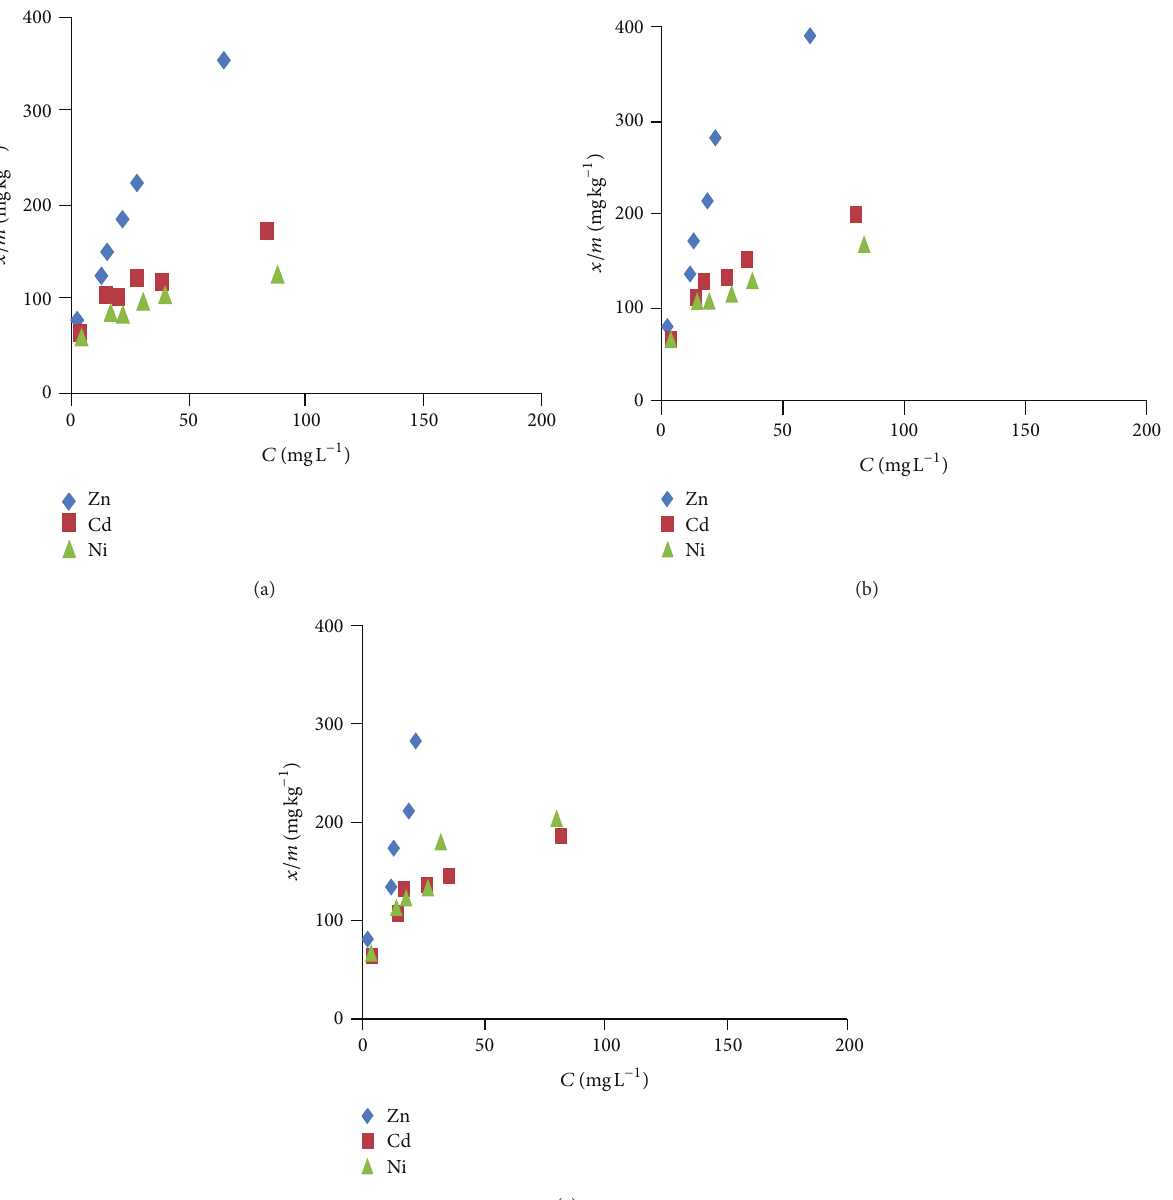
Figure 1: Noncompetitive adsorption isotherms of Zn, Cd, and Ni in soil control (a), T 2 (b), and T 3 (c) samples. Data are means of triplicate